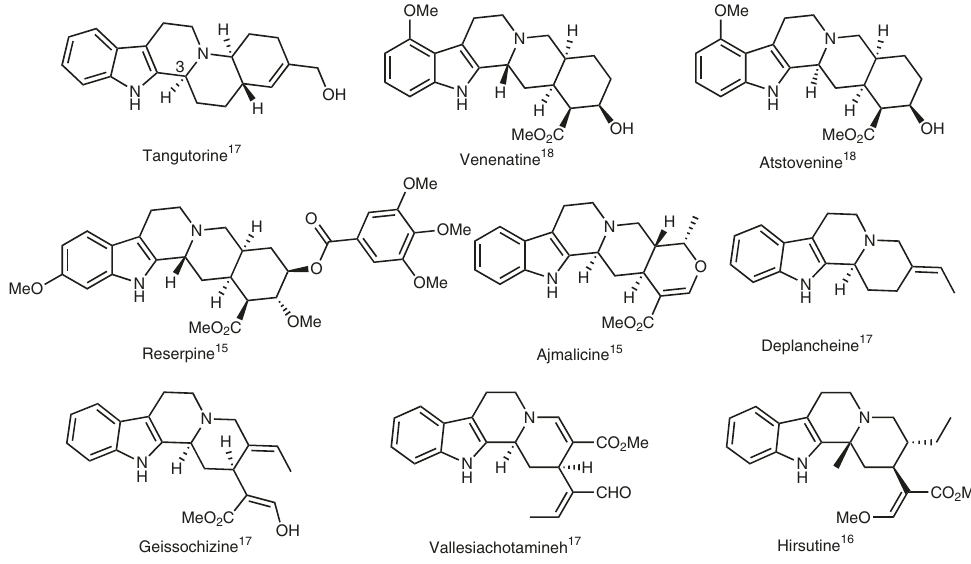
Fig. 1 Representative examples of bioactive octahydroindolo[2,3-a]quinolizine